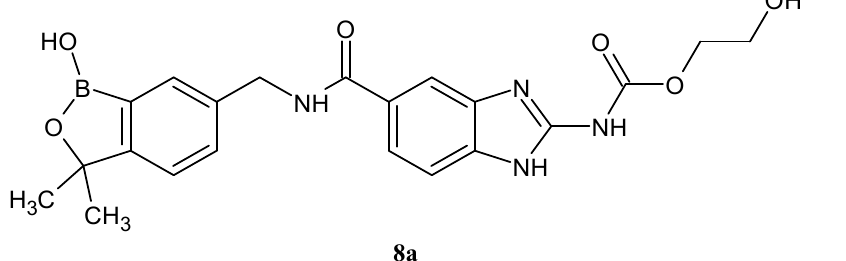
Figure 4. The structures of benzimidazole derivatives .